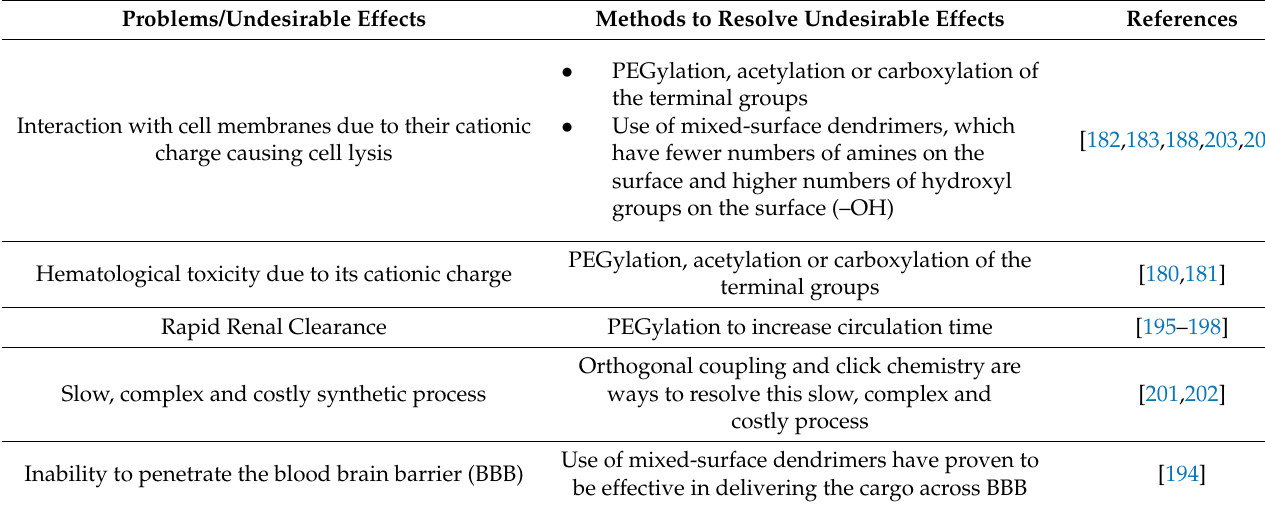
Table 3. Problems of dendrimers and ways to overcome the undesirable